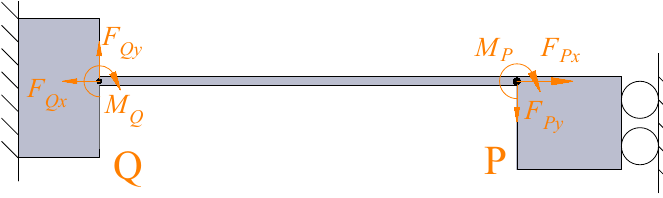
Figure 7. Static body analysis of the guiding